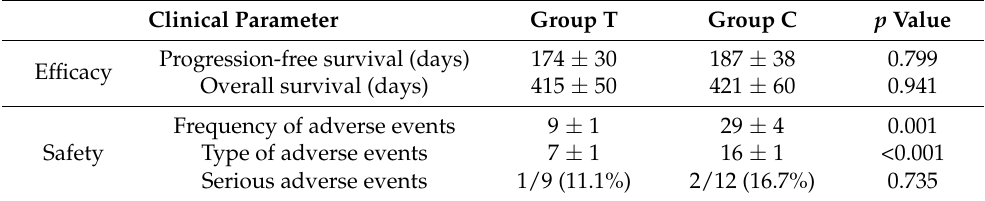
Table 2. Differences of clinical efficacy and safety between C and T. Clinical Parameter Group T Group